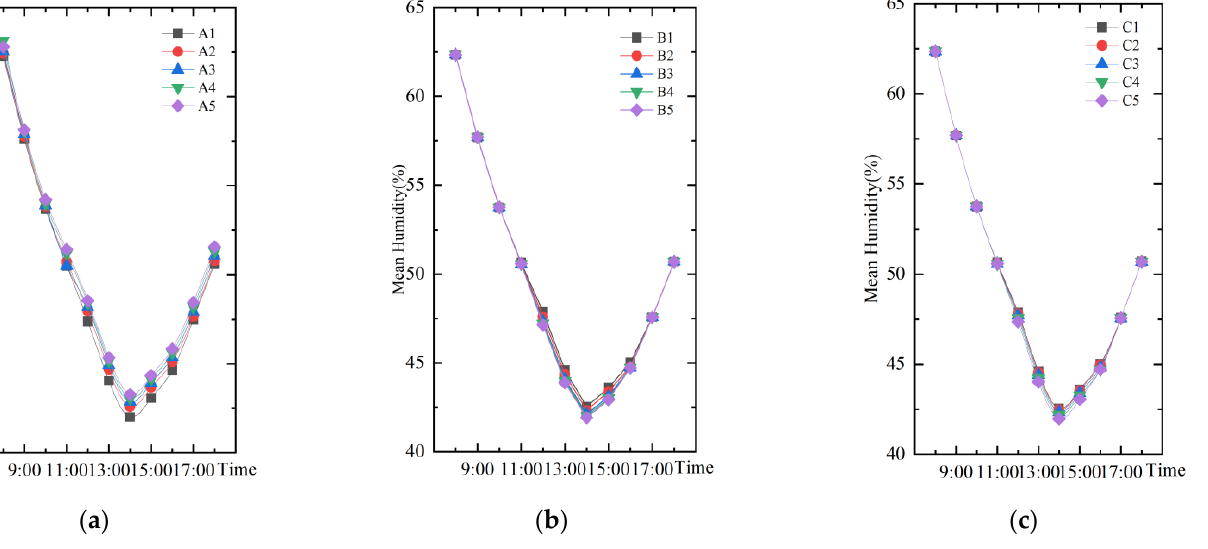
Figure 8. The trend of temporal mean humidity change for different water body layout factors: ( a ) Water body area index; ( b ) Water body dispersion index; ( c ) Water body shape index.